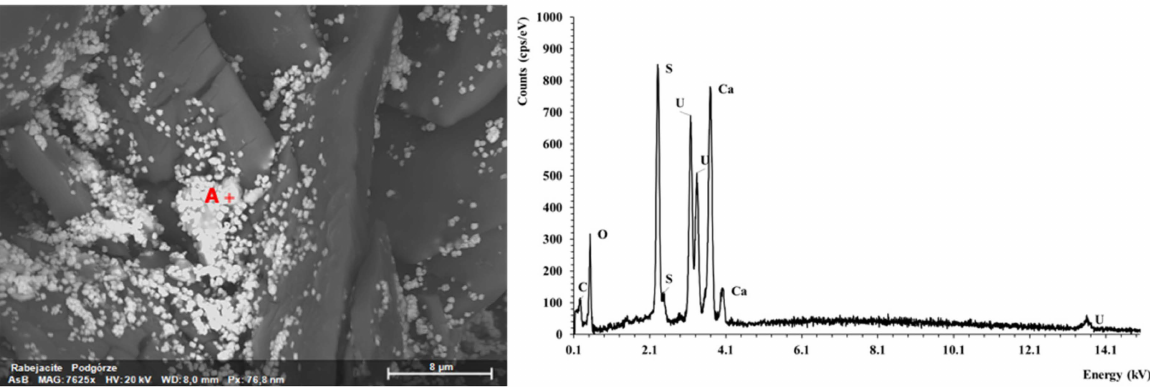
Figure 12. SEM photo of rabejacite aggregates with EDS spectrum (Point